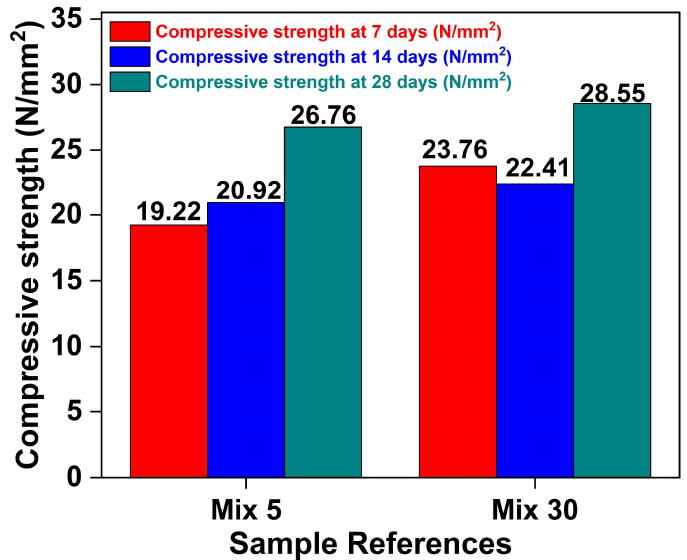
Figure 5. Compressive strength at 7, 14 and 28 days of curing age.